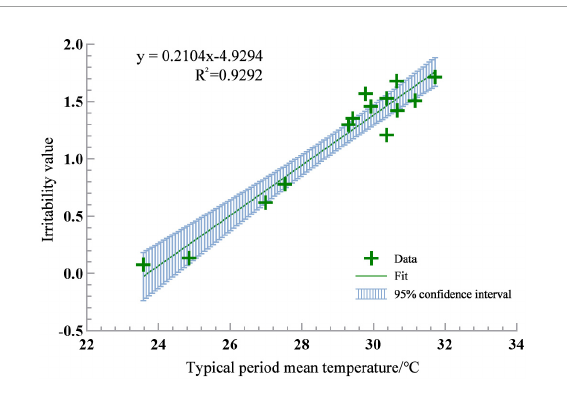
FIGURE5 Relational model between average temperature and average irritability value in typical